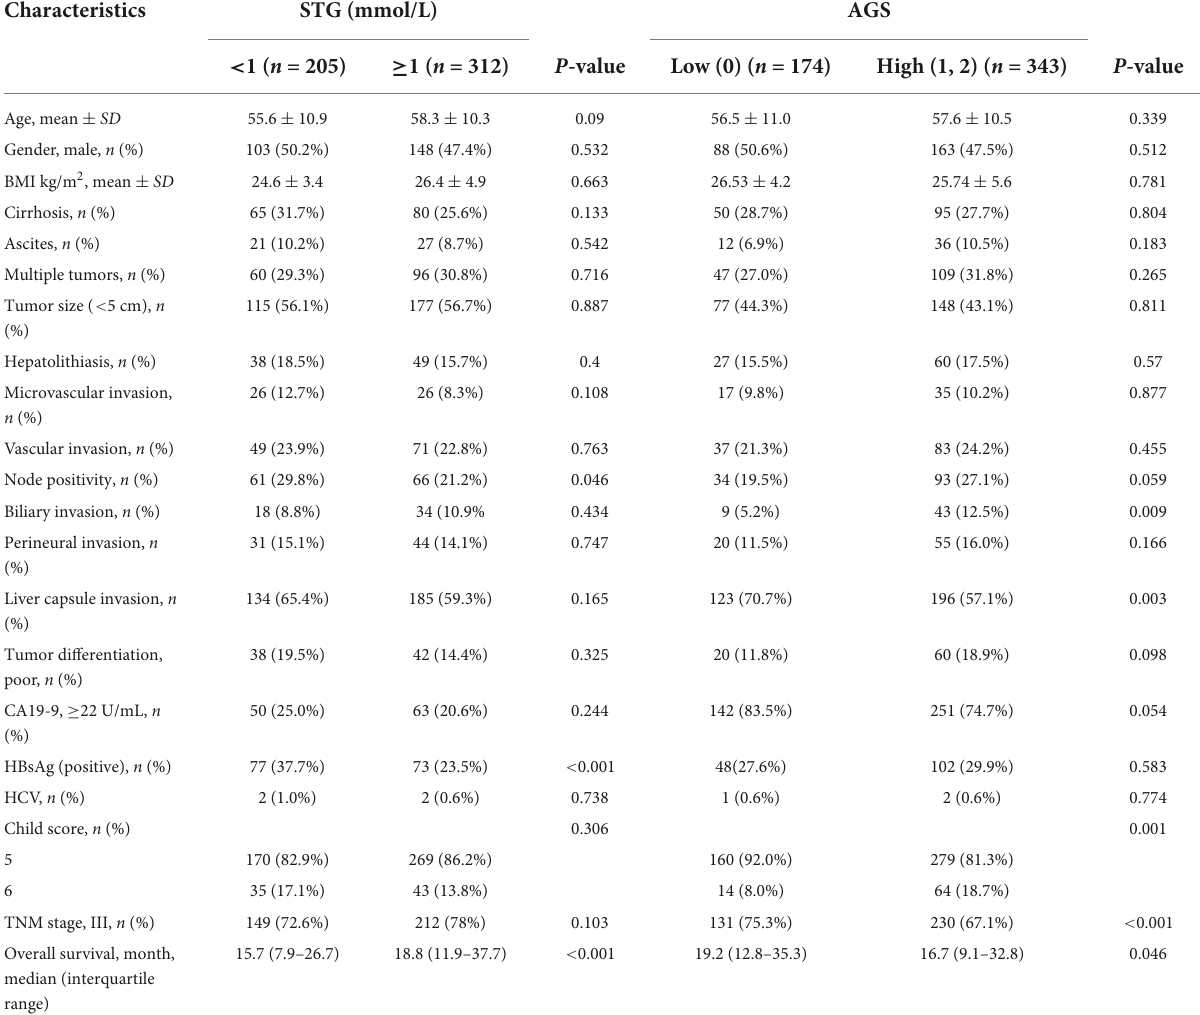
TABLE 2 Comparison of characteristics with the different serum triglyceride levels and AGS grades of 517 ICC patients treated with surgical resection in the discovery set.